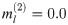
Equilibrium fractions change with relative chirality.(A) shows the steady-state spatial structure for two strains with opposite handedness, but unequal magnitudes of chirality (f* ≠ 1/2). (B) shows the relative abundance of the strains as a function of their relative chiralities. This relationship is approximately linear in agreement with Eq (5); see also S1 and S2 Figs. Here, m0 = ms = mb = md = 0, g = 0.1 for both strains. The chirality of the strains is shown with thick white arrows. In (A) ml(2)=0.0, mr(2)=0.05, ml(2)=0.00725, mr(2)=0.0425, N = 100. In (B), the chirality of the strains was varied with the difference in their chiralities (ml(1)−mr(1))−(ml(2)−mr(2))=0.1 and ml + mr = 0.1 at N = 400. Length of lattice was varied to ensure steady state was reached.